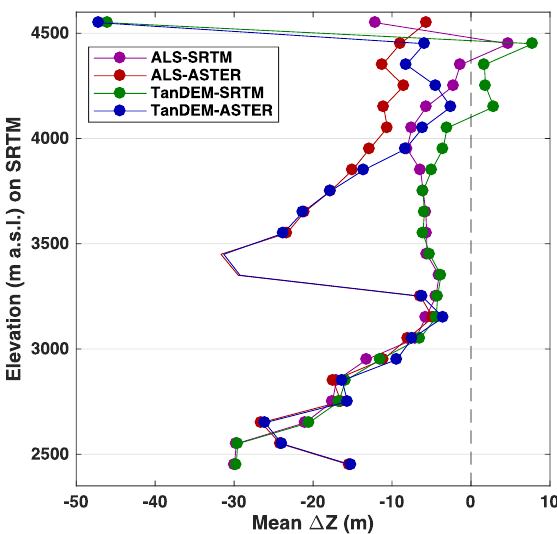
Figure 9. Vertical profile of measured ice elevation change on Universidad Glacier. All ∆ Z measurements were averaged per 100 m elevation bin. Only GA pixels were